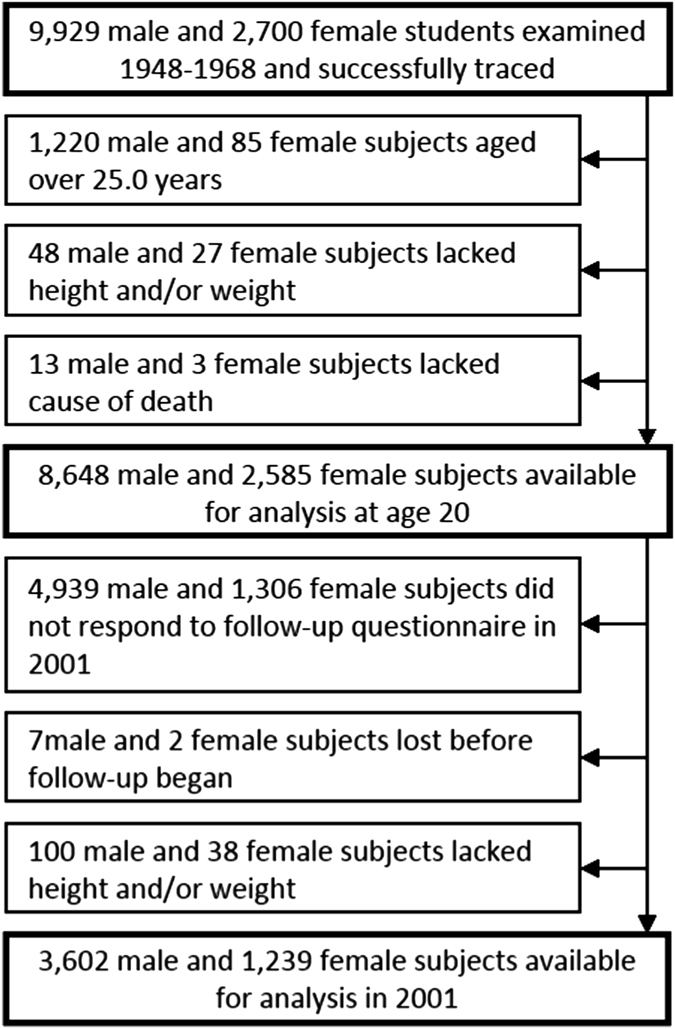
Flow of participants through the study.